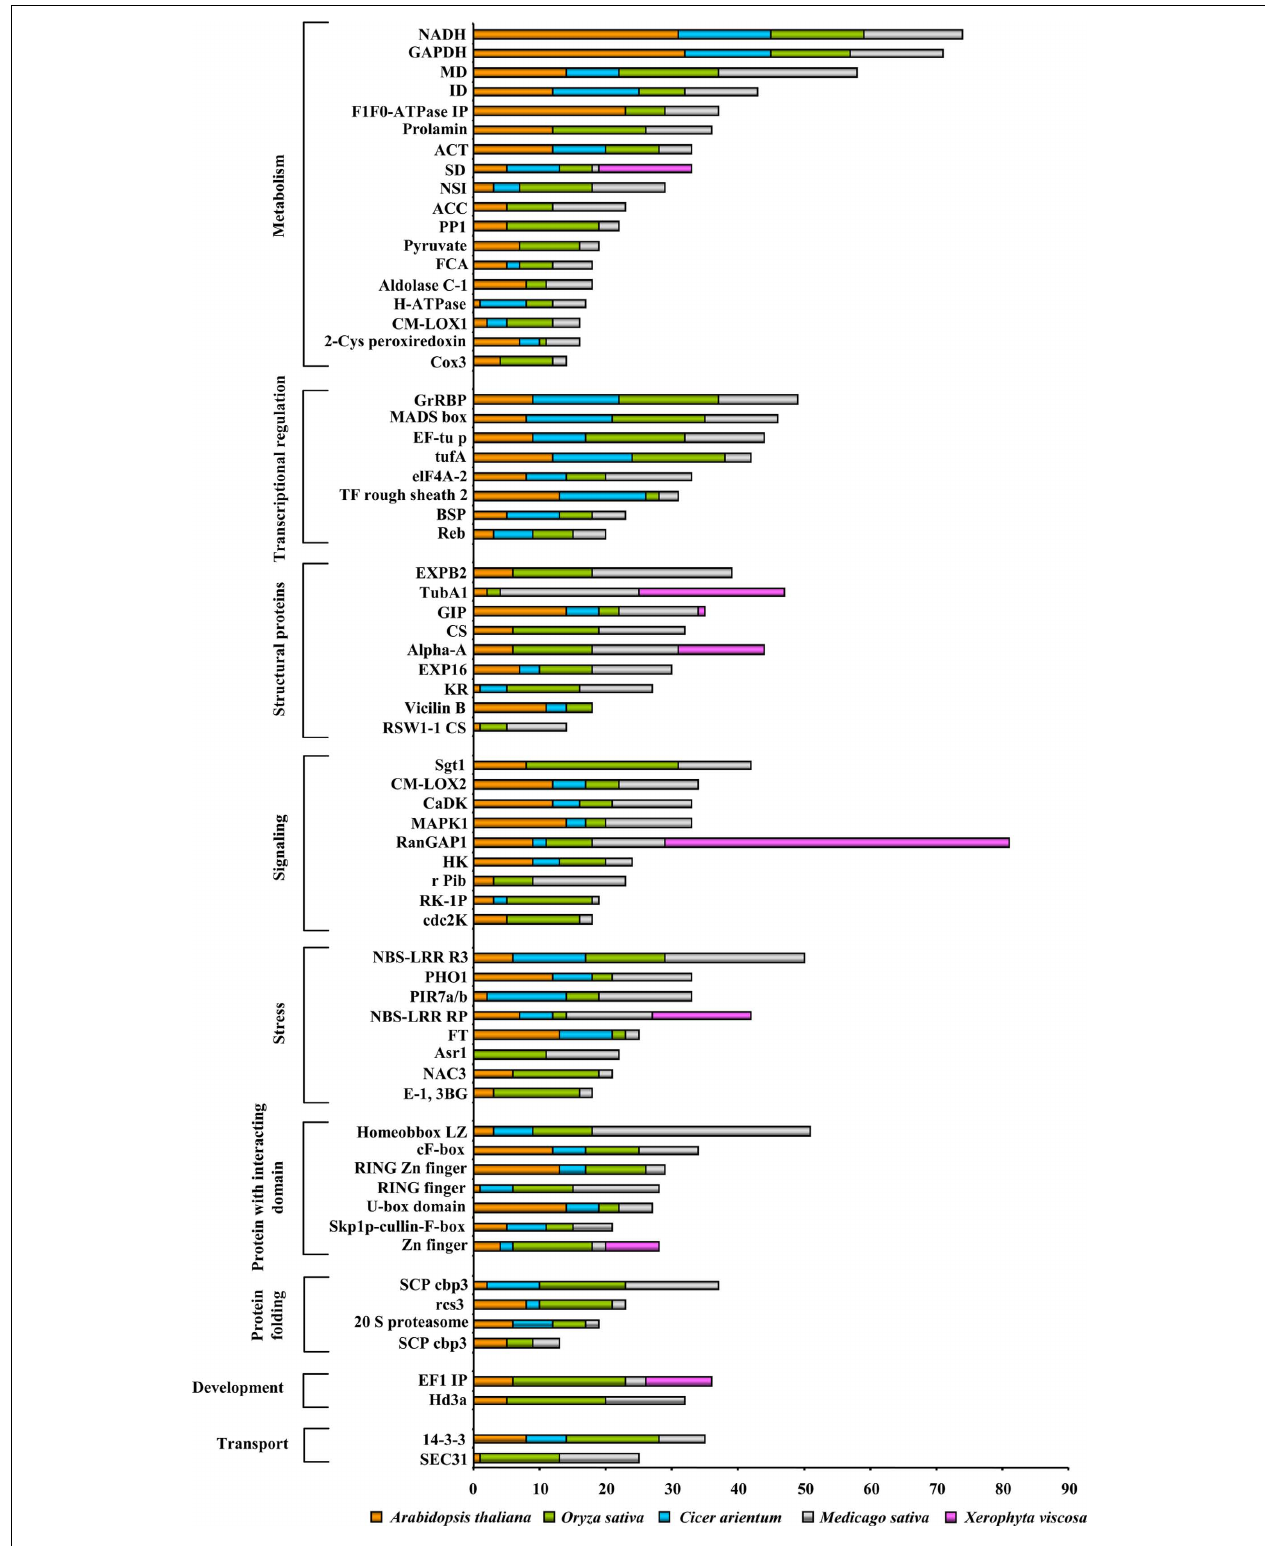
FIGURE 3 | Comparative abiotic stress-responsive nuclear proteome:The functional classification of the identified proteins was according to the biological processes in which they are involved. The length of the bars indicates the number of proteins present in a particular stress.